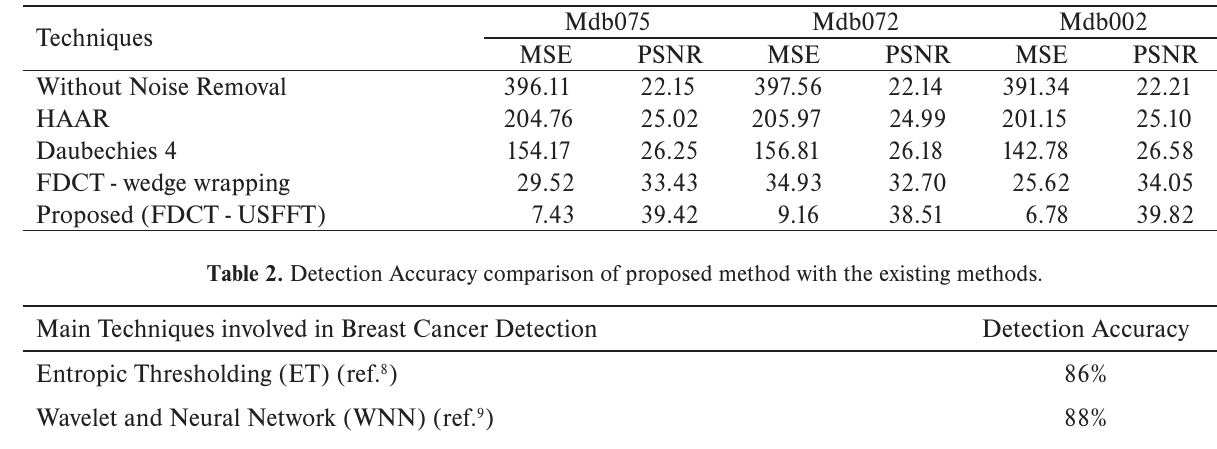
Table 1. MSE and PSNR comparison of proposed method with the existing methods.